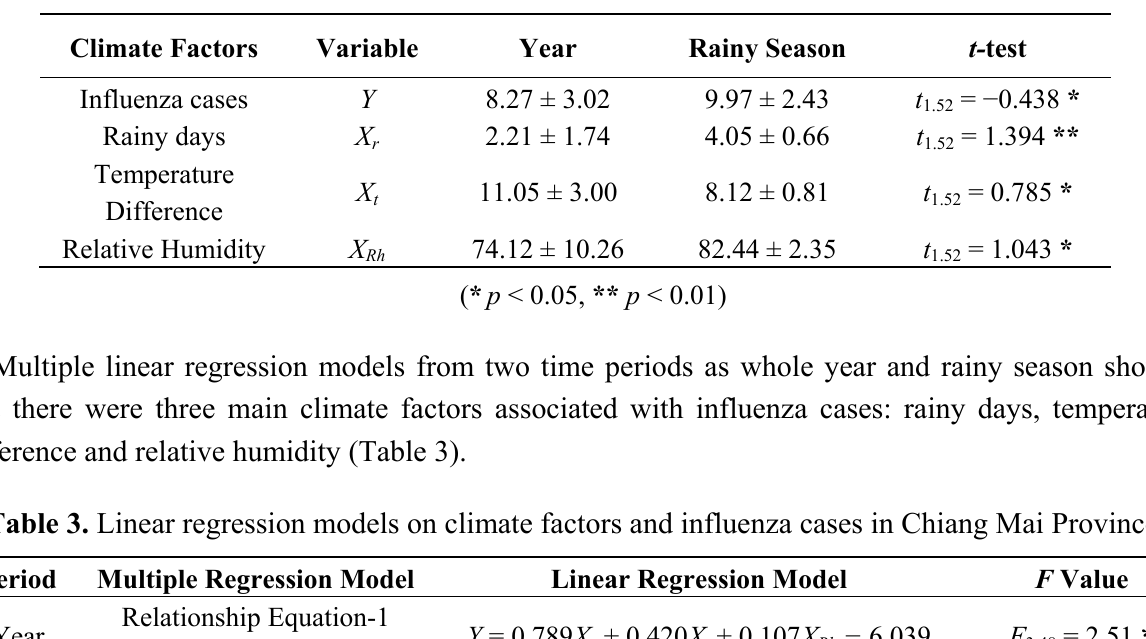
Table 2. Mean ± SD of climate factors on Chiang Mai Province.